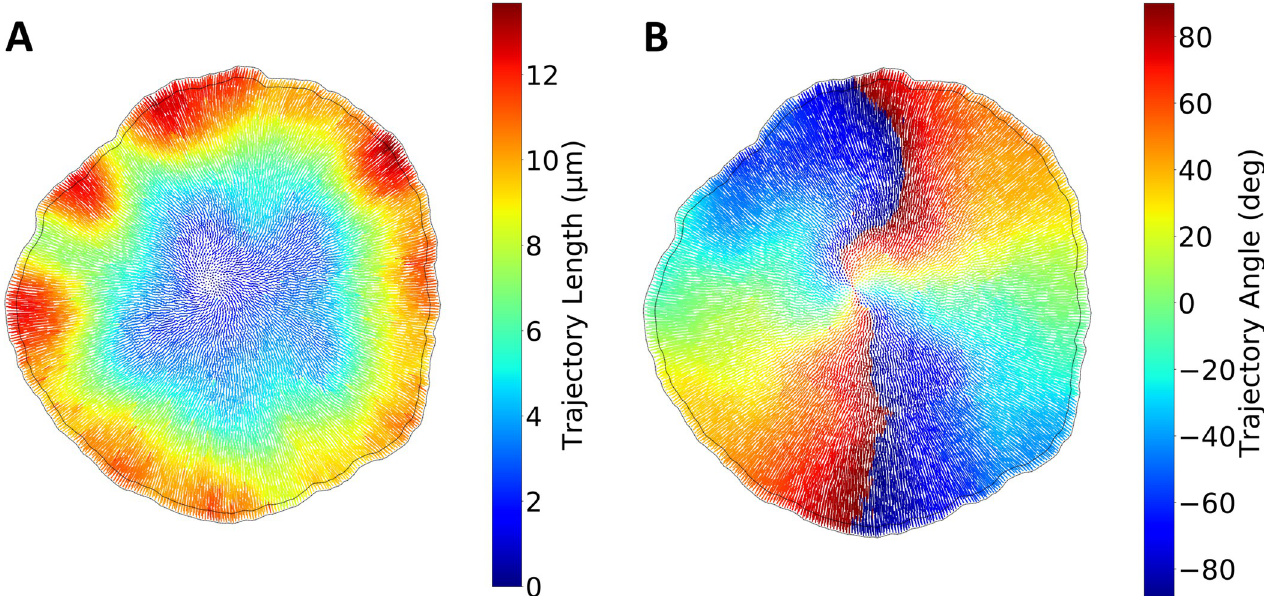
Fig 2. Single cell trajectory characteristics during avalanches. A: Cell trajectories during an avalanche, color coded with their respective length. The cells in the outer region displace the most, whereas the trajectories are shorter at the center of the tissue. The tissue boundary before and after the avalanche is outlined, visualizing the net expansion of the tissue. B: Cell trajectories during an avalanche, color coded with their respective angle relative to the x-axis, as defined by the inverse tangent function. On the outer region of the tissue, the trajectories are approximately radial. The vorticity is evident towards the center of the tissue, where the trajectory angles start to